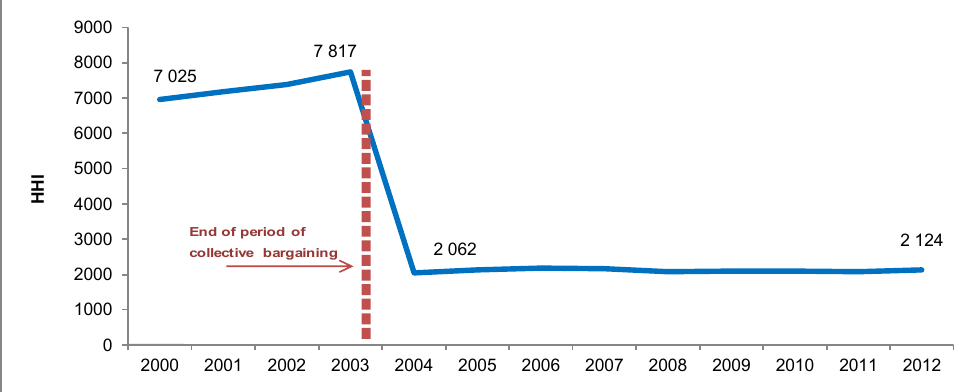
Market concentration of private hospitals (HHI),